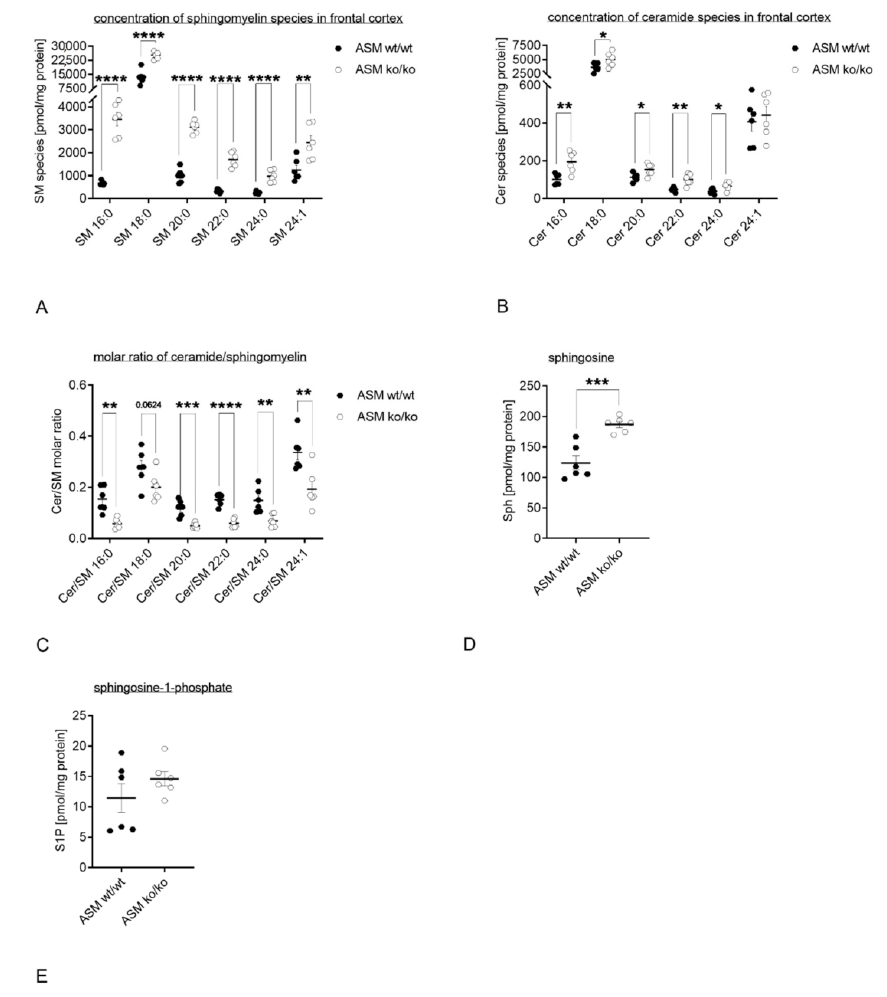
Figure 2. Genetic ASM deficiency impacts the sphingolipidome in the murine frontal cortex. ( A ). Concentrations of all analyzed SM species were significantly increased. ( B ). The concentrations of Cer 16:0, Cer 18:0, Cer 20:0, Cer 22:0, as well as Cer 24:0 were elevated. ( C ). The overall molar ratio of Cer/SM was decreased in ASM KO mice compared with WT mice. ( D ). The concentrations of sphingosine were significantly increased in ASM KO mice vs. ASM WT. ( E ). The concentration of S1P did not show any significant change in ASM KO mice. Bars indicate mean ± SEM; n = 6 animals; * p ≤ 0.05, ** p ≤ 0.01, *** p ≤ 0.001, **** p ≤